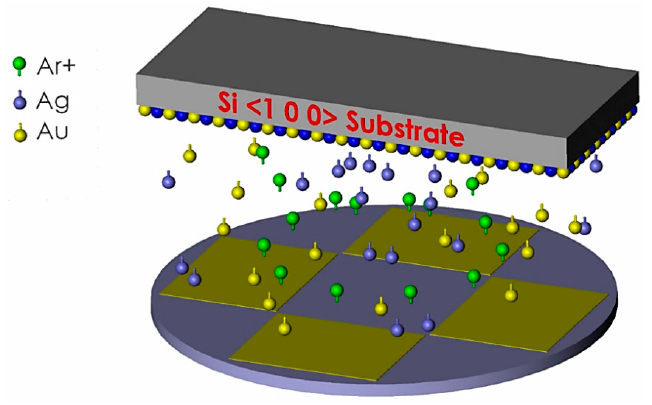
Figure 3. Schematic representation of the magnetron sputtering method with a compound sputter- ing target.